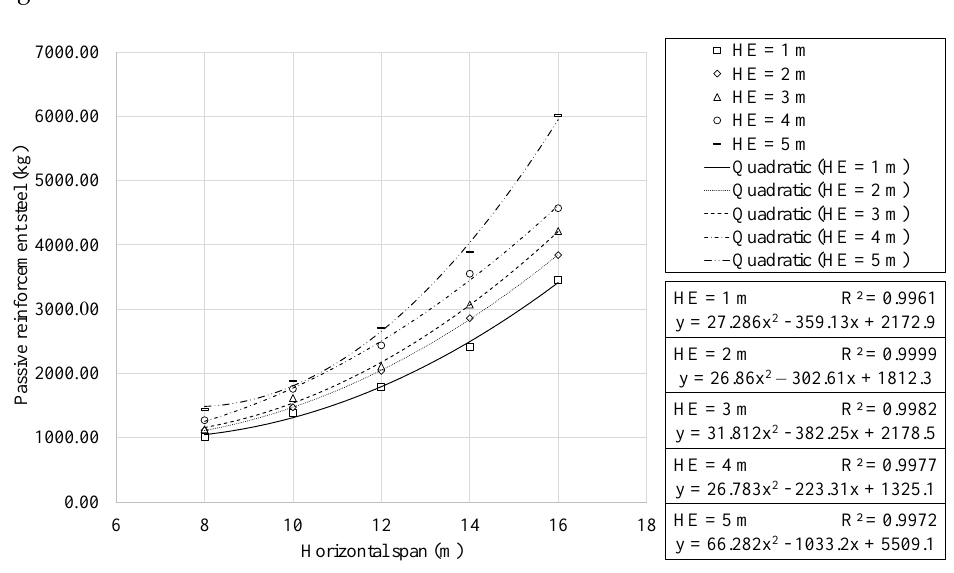
Figure 11. Passive reinforcement steel as function of horizontal span, for each earth cover depth.